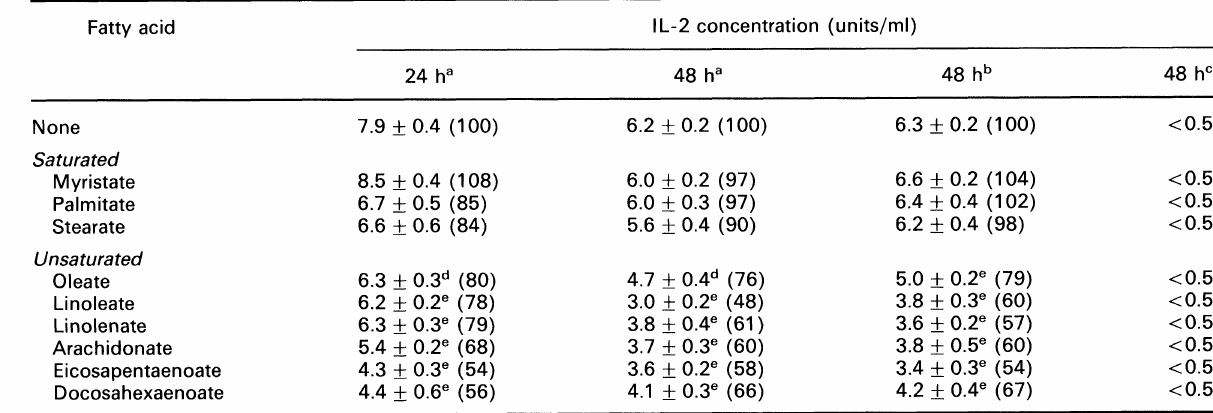
Table 1. Effect of fatty acids on the concentration of L-2 in the culture medium of Con A-stimulated rat lymphocytes Fatty acid